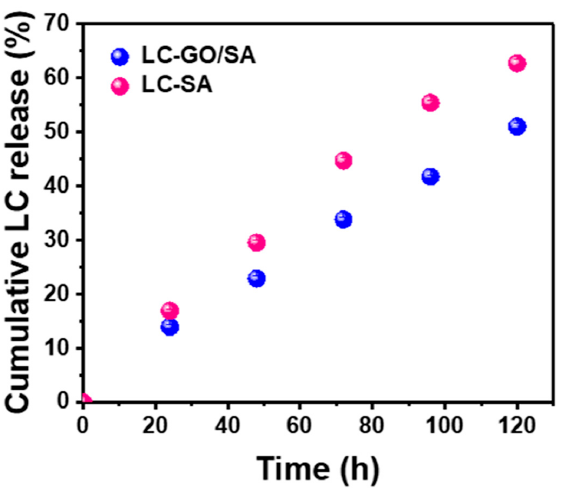
Figure 5. The in vitro lidocaine hydrochloride release profiles of SA and GO-SA systems in PBS solution. The error bars in the graph represent standard deviations (n = 4).